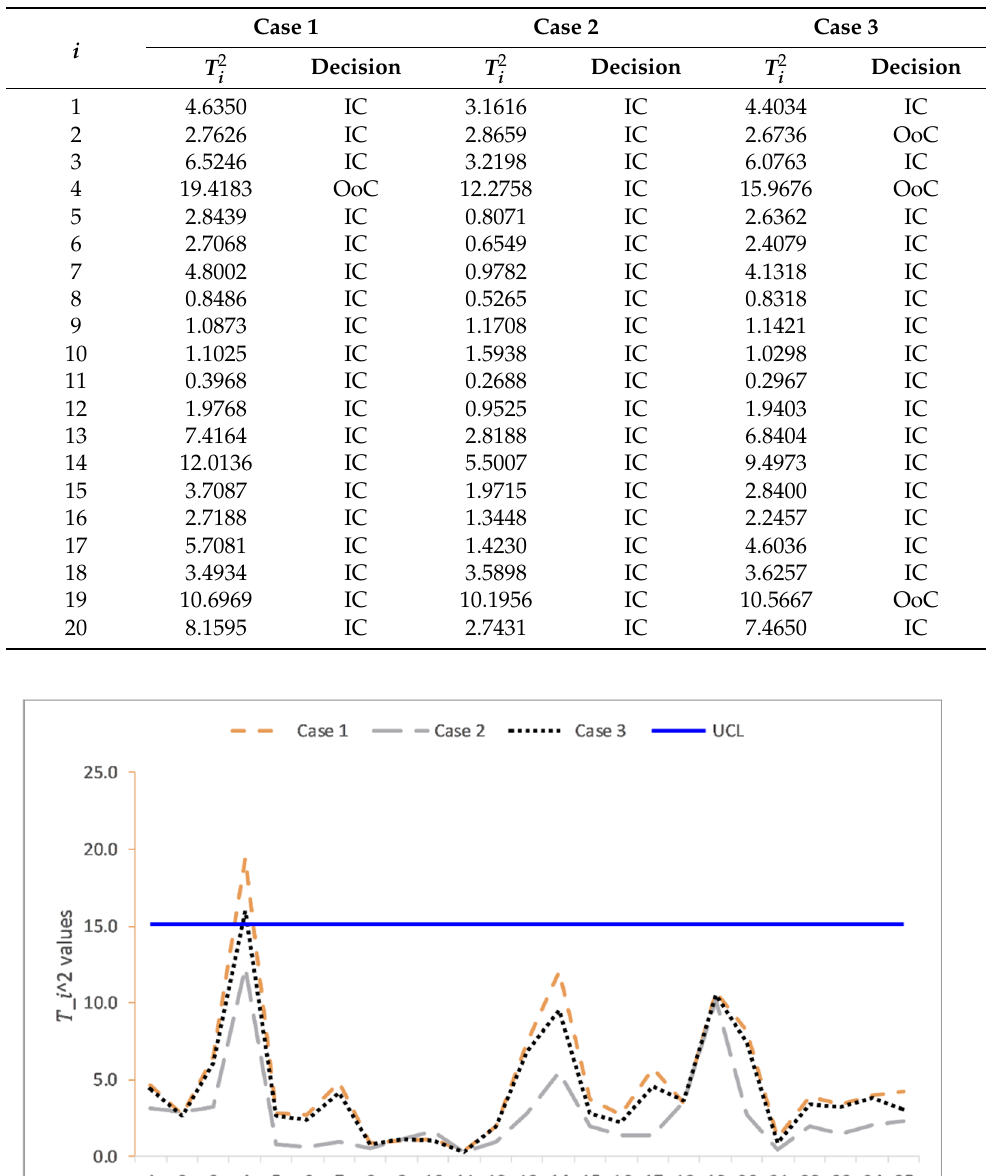
Table 8. T 2 values and decisions of the three cases with θ = 0.07, ω = 3, and v = 5. i